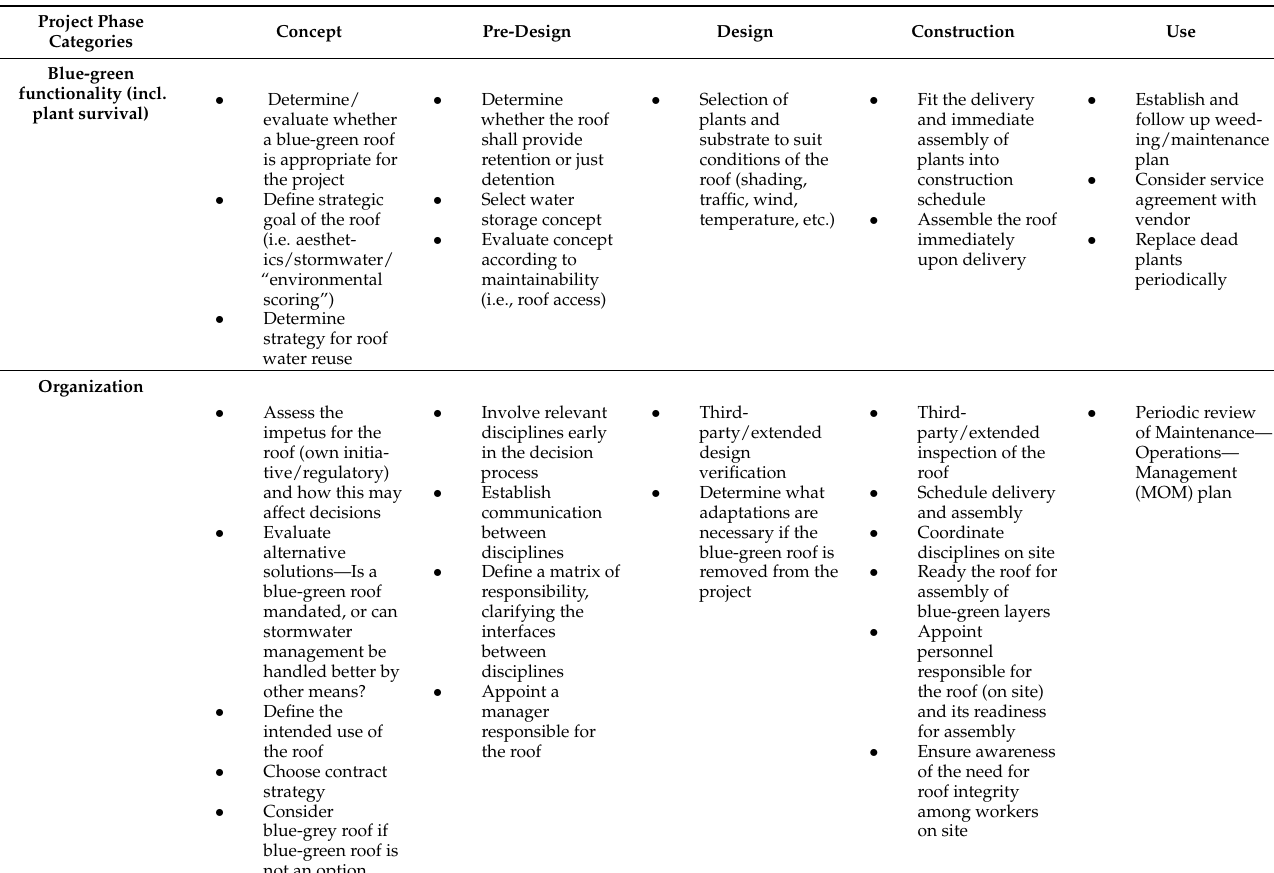
Table A1. Matrix of key actions in the risk reduction